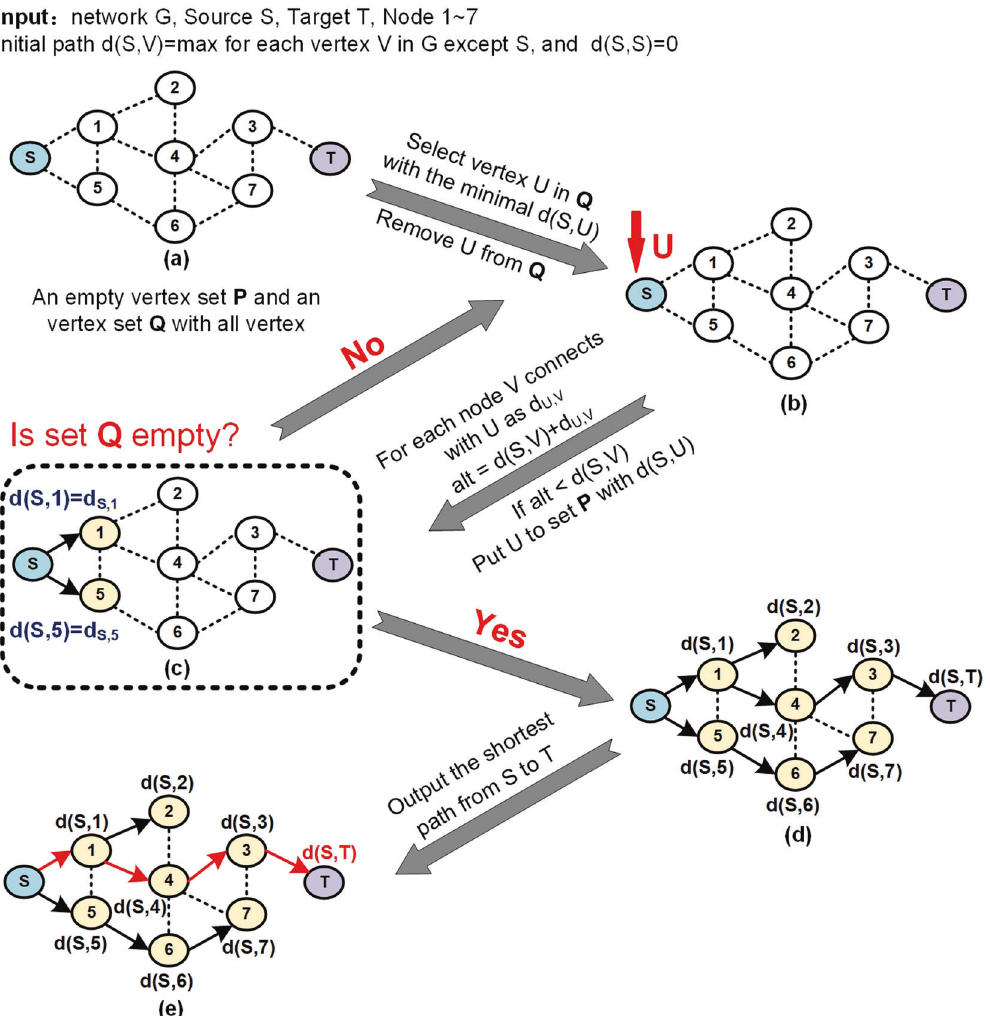
Fig. 3 The fl ow chart of the shortest path algorithm. The red paths in the bottom network are the identi fi ed shortest path from node S to